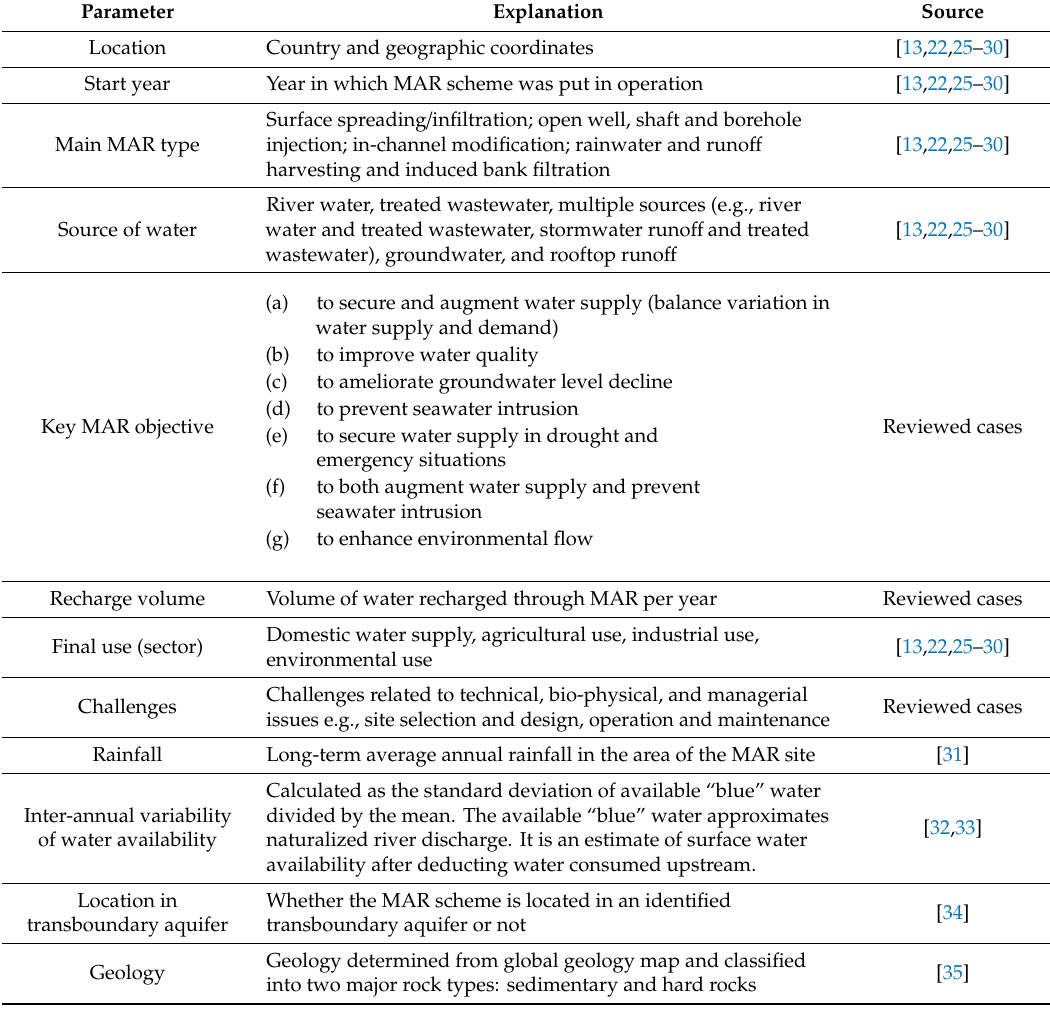
Table 1. Managed aquifer recharge (MAR) classification